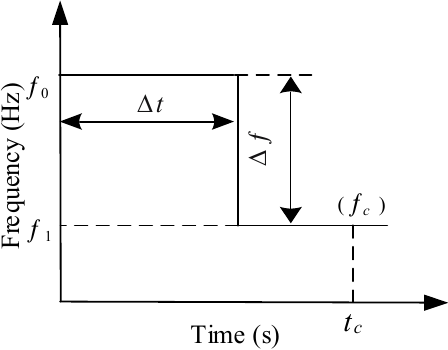
7 of 14 Metal tube Annular v-groove Figure 5. Schematic diagram and physical photos of specimen geometric parameters. The separation test uses 30 6 φ × GCr15 steel seamless steel tube, where the outer diameter = 30 mm, the wall thickness = 6 mm and L 1 = 50 mm. The geometric parameters of the V-notch are taken as ρ = 0.2 mm, α = 90° and h = 1.2 mm, as shown in Table 1. Table 1. Test tube materials and parameters. Material